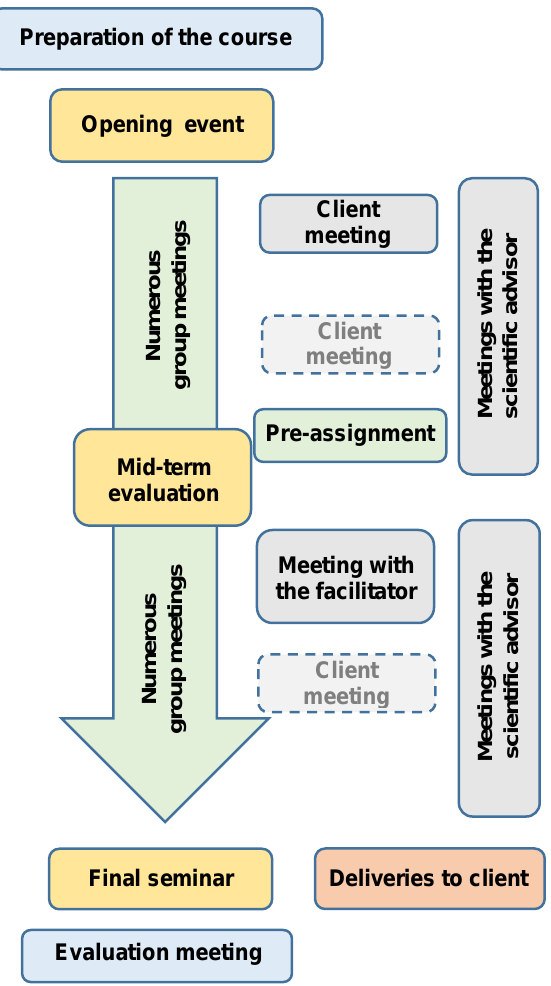
Figure 2. The structure of the project course. The number of meetings with the client and the scientific advisor can vary, depending on the demand.